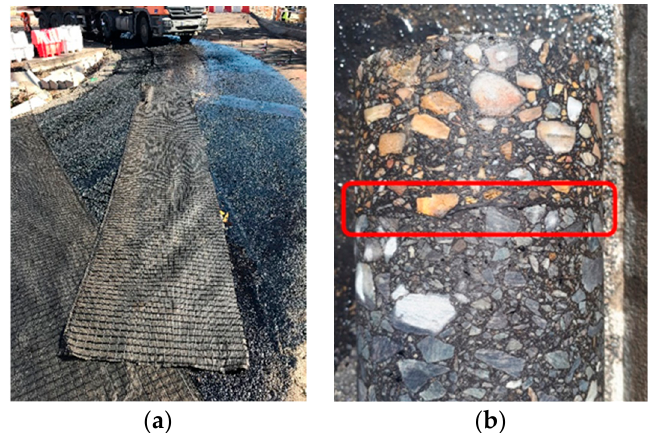
Figure 3. ( a ) Geogrid overlap poorly executed; ( b ) Sample of rehabbed